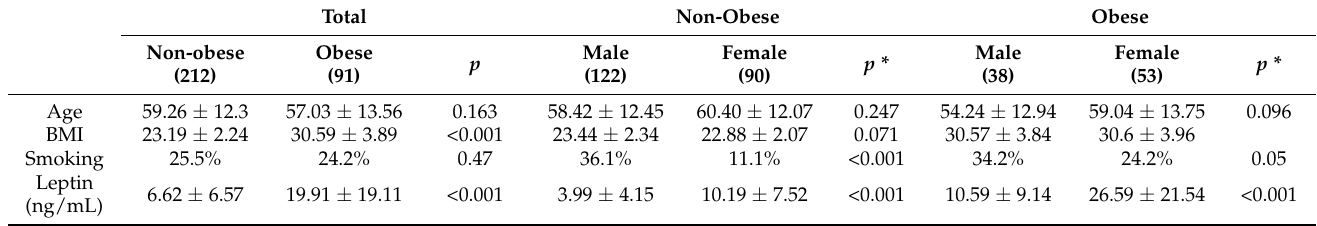
Table 2. Baseline characteristics of study subjects in relation to sex and obesity